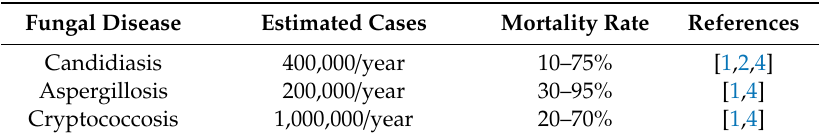
Table 1. Annual worldwide fungal infections.